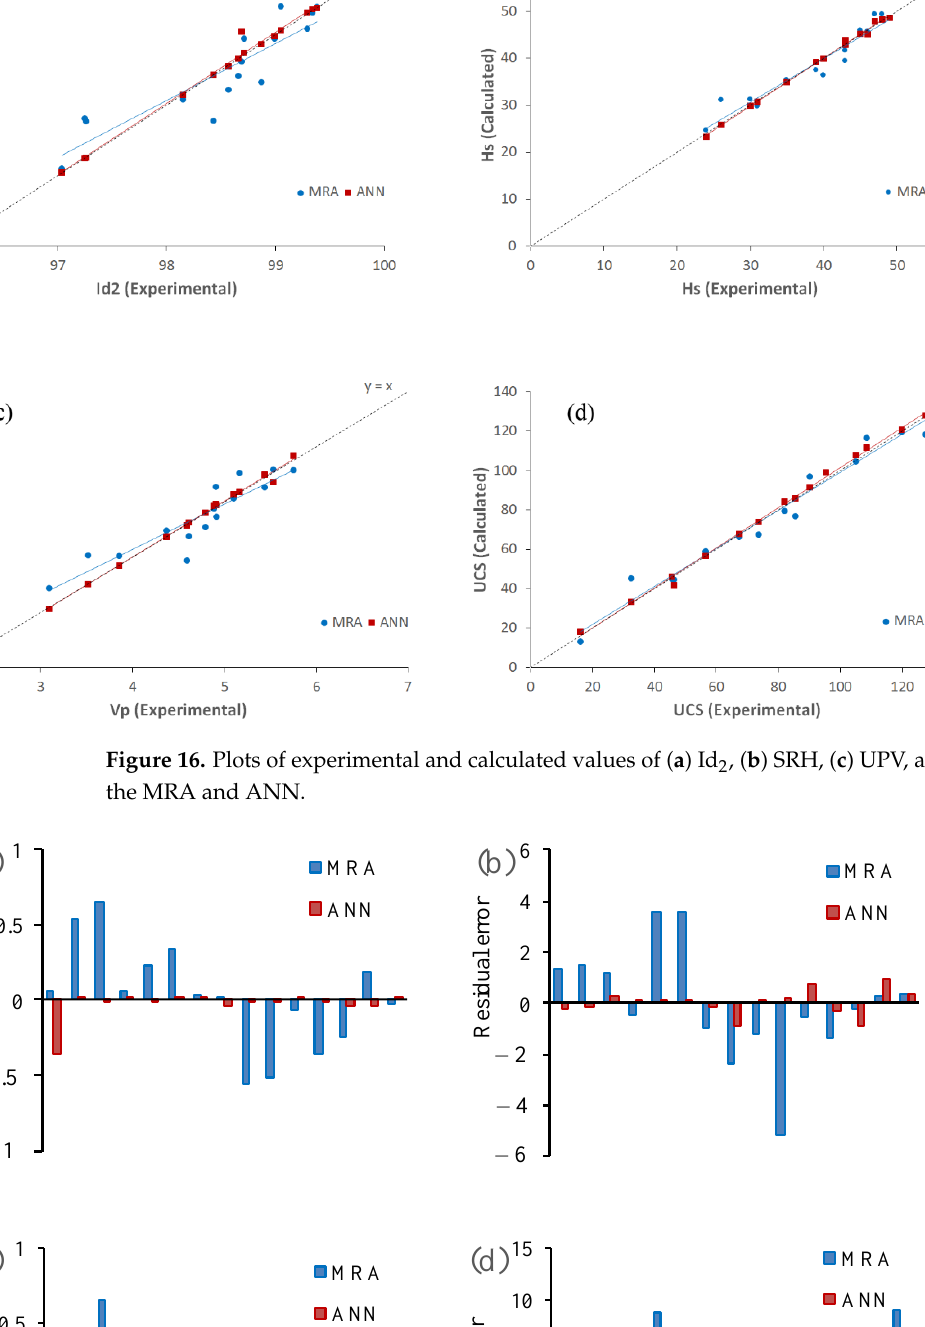
Table 12. Residual error values of MR and ANN models.